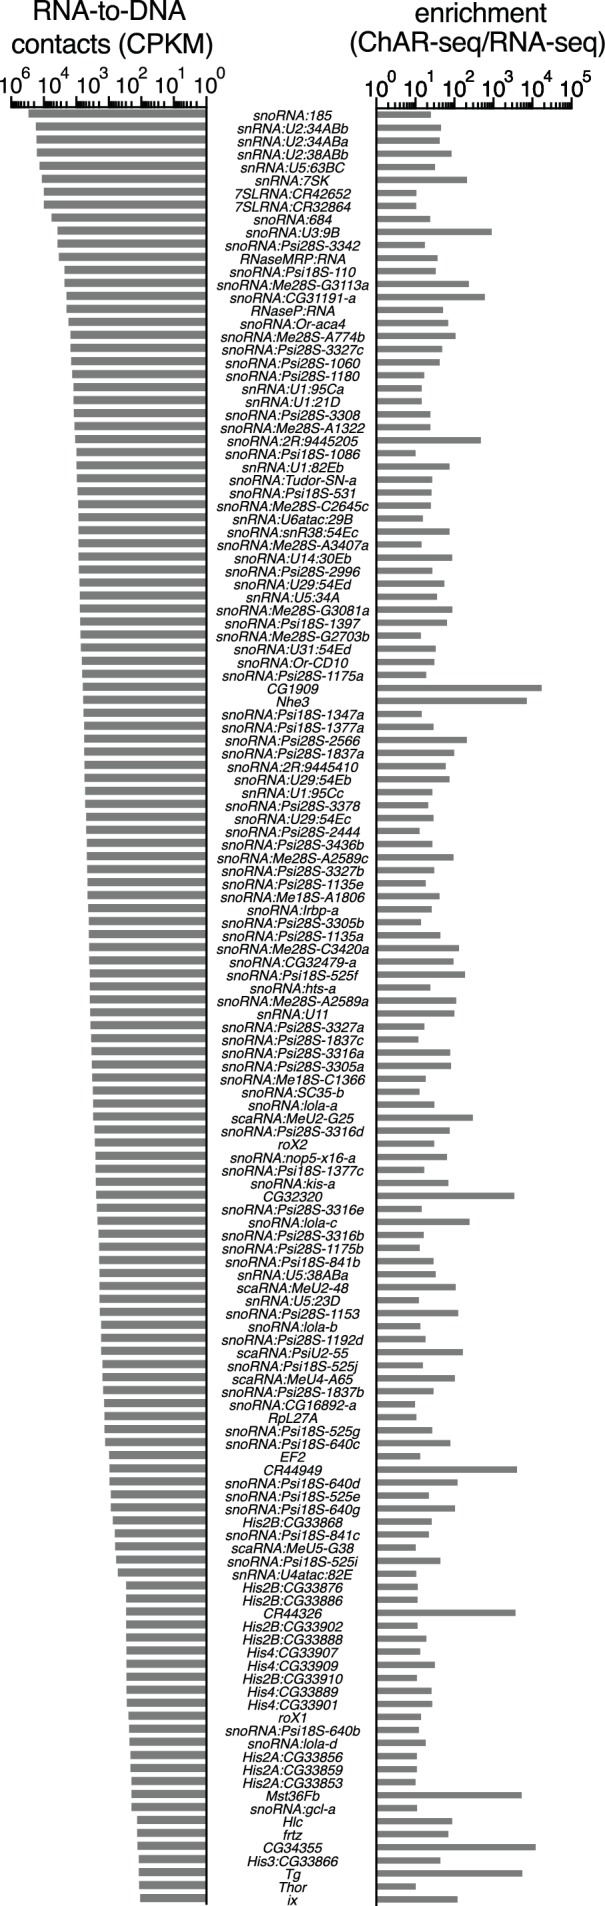
Chromatin-associated RNAs ranked according to CPKM and enrichment in ChAR-seq over RNA-seq.RNAs are sorted according to the abundance of their genome-wide contacts (CPKM, left bars). Right bars represent the fold-enrichment of each RNA in ChAR-seq over RNA-seq.